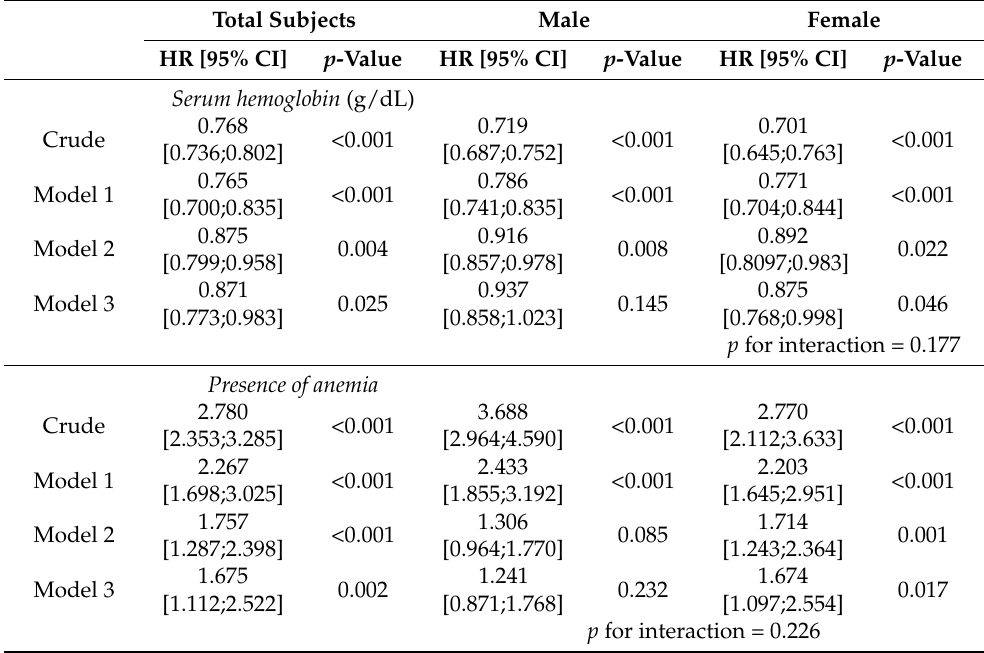
Figure 3. Restricted cubic spline curve of hazard ratio of serum hemoglobin for Immunoglobulin A (IgA) nephropathy progression by sex. Table 2. Hazard ratio of hemoglobin for renal prognosis of IgA nephropathy with Cox proportional hazard models by